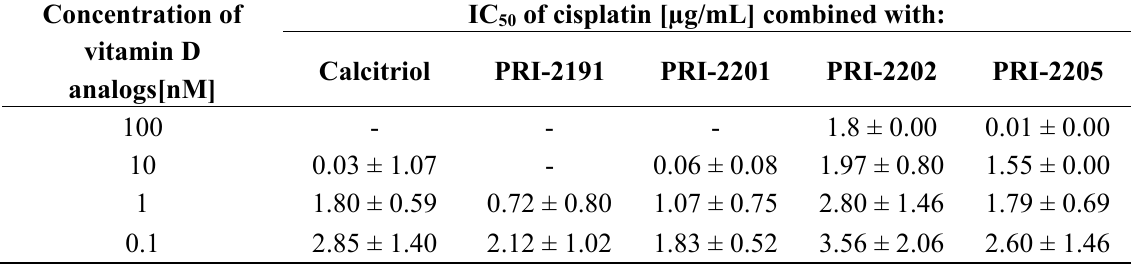
Table 2. The antiproliferative activity of cisplatin used after preincubation with calcitriol or its analogs against HL-60 cells.